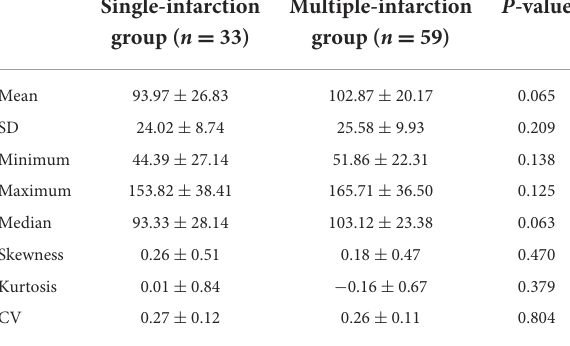
TABLE 3 Histogram features between single-infarction and multiple-infarction groups.